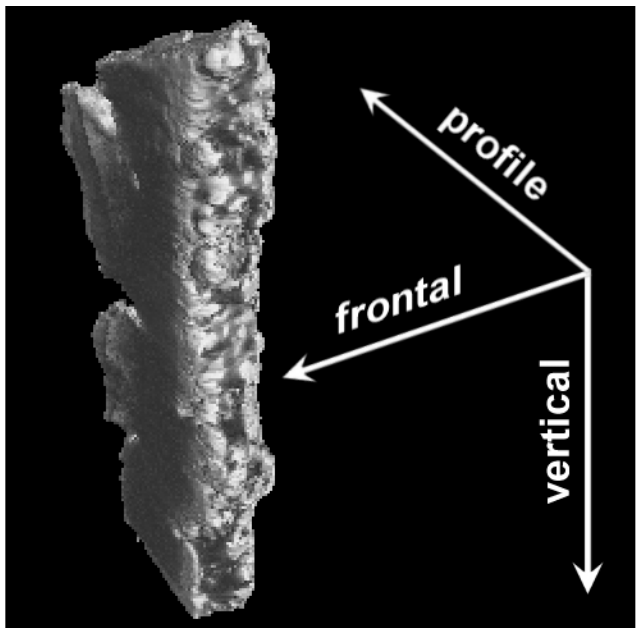
Figure 2. The sample’s scanning directions by X-ray tomography.